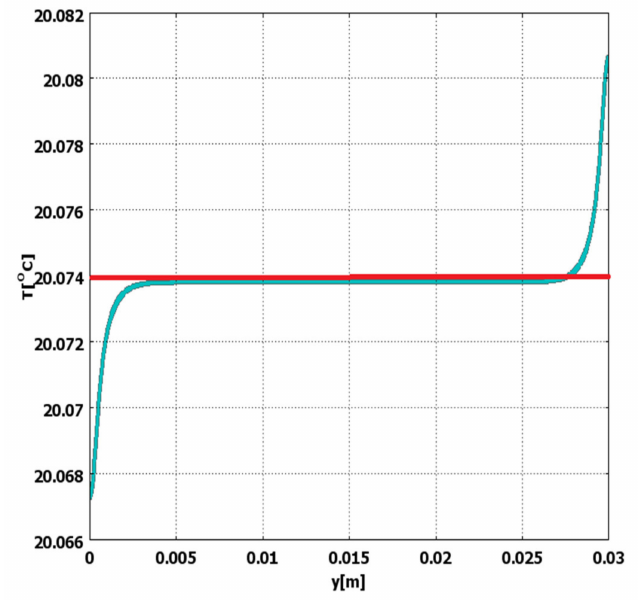
Figure 6. Temperature at the solid interface for a toluene–methanol binary fluid at x = e f = 5 · 10 − 4 m. The analytical solution is given in red and the numerical calculation is shown in green.